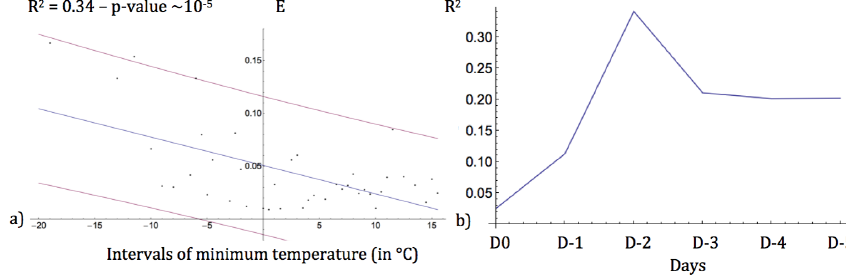
Figure 9. Same as Fig. 7 for Auvergne. Minimum temperature on D 2 (a) . (b) R 2 of rockfall vs. minimum temperature of several